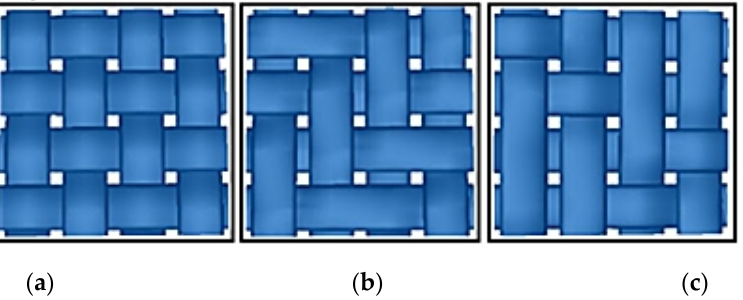
Figure 3. Schematic representation of weave pattern: ( a ) Plain; ( b ) Twill; ( c ) Satin.